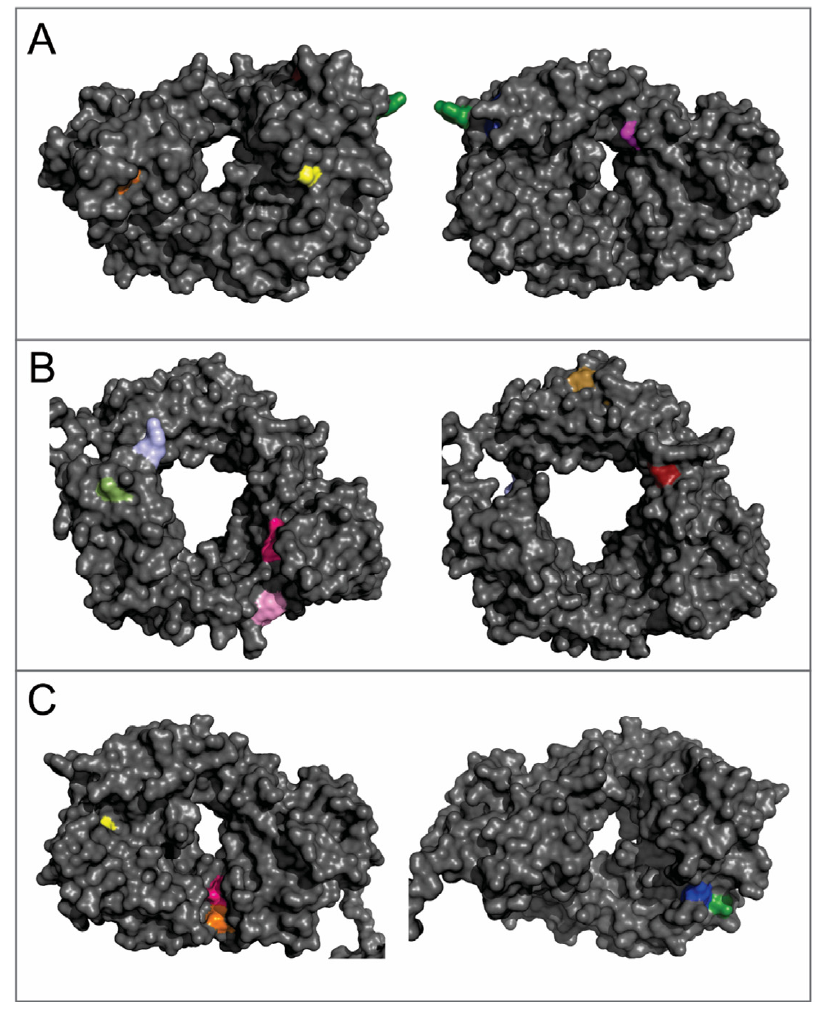
Figure 8. Homology models of mAb1 with the location of Tyr residues. ( A ) The heavy chain Fab region; ( B ) the heavy chain Fc region; and ( C ) the light chain. All Tyr residues are in color; the other residues are